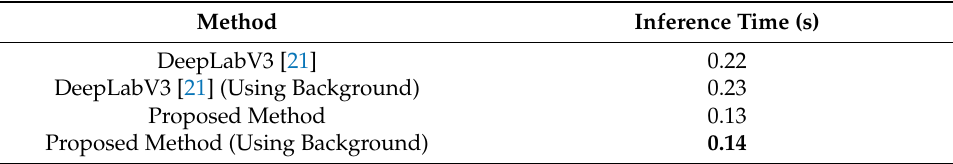
Table 6. Inference time for the encoder-decoder